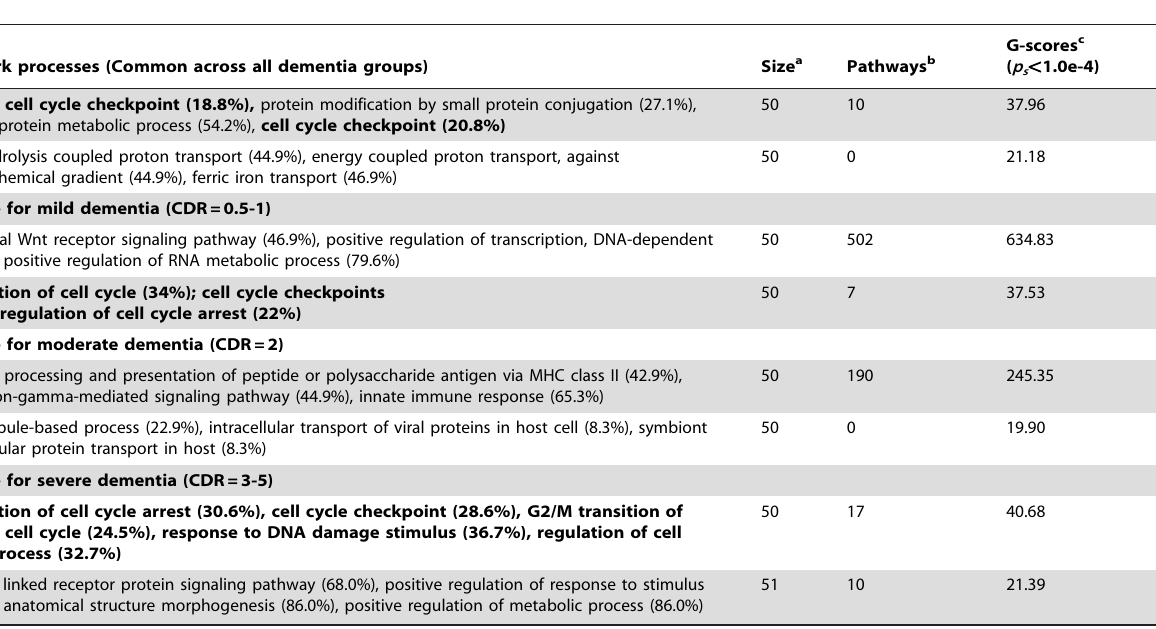
Table 1. Most relevant common and unique gene networks in the STG (BA22) derived from MetaCore analysis by comparing groups of cognitively impaired individuals with cognitively intact controls (CDR= 0).